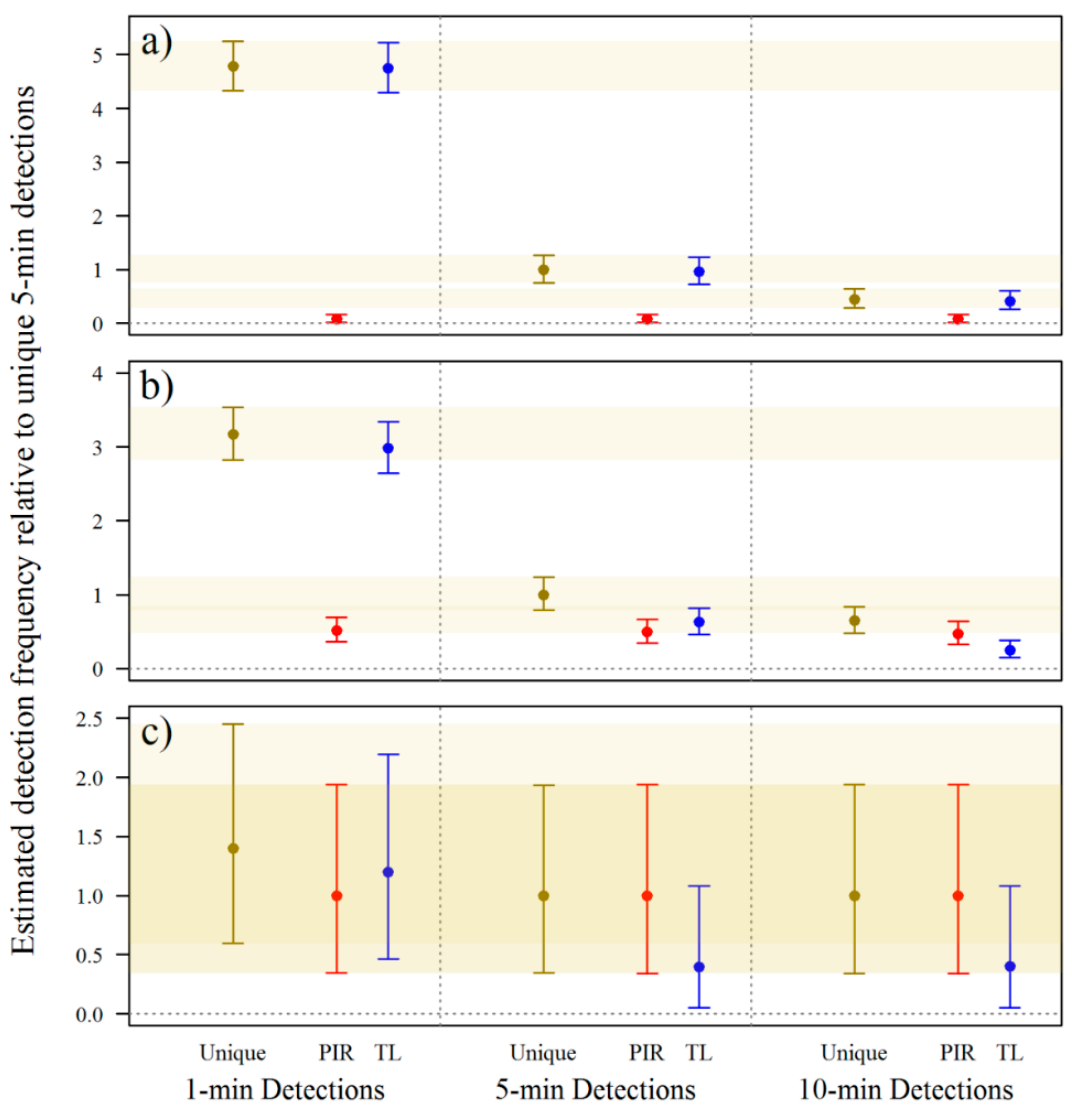
Figure 4. Estimates of the proportion of detection events during Dec 2013–Feb 2014 of ( a ) small lizards; ( b ) medium–large lizards; and ( c ) snakes as a function of trigger mechanism. Estimates are standardised to unique 5-min detections. Trigger mechanism scenarios are unique detections, passive infrared (PIR) trigger only detections, and time-lapse (TL) trigger only detections. Central dots represent the mean of the posterior distributions and bars represent 95% credible intervals.